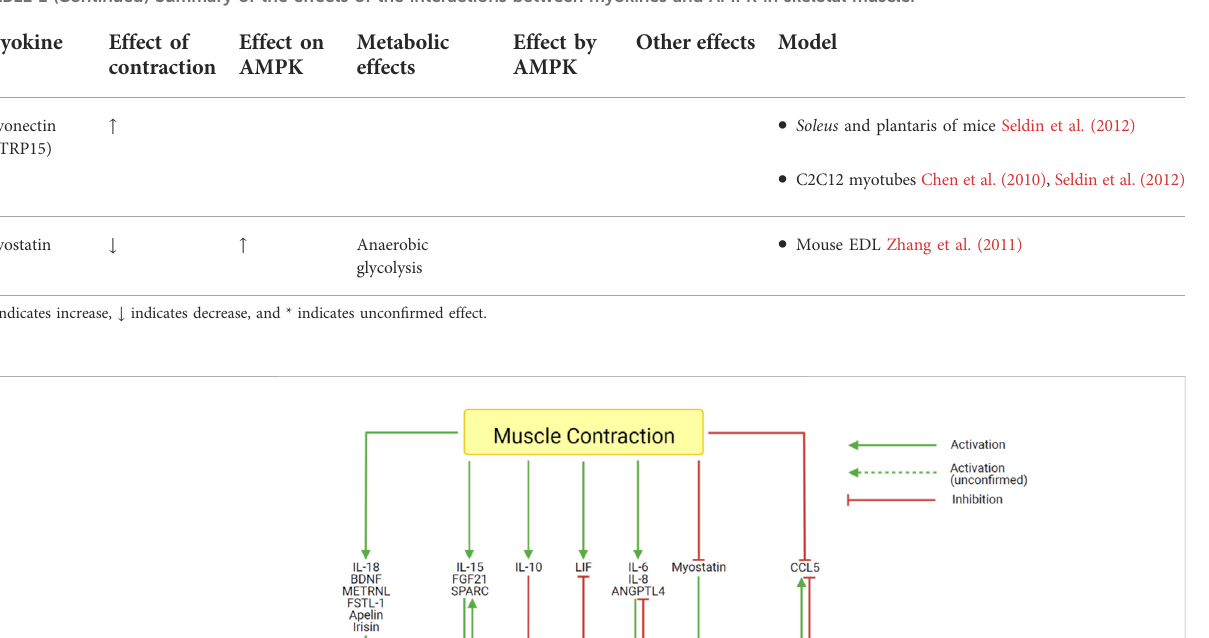
TABLE 1 ( Continued ) Summary of the effects of the interactions between myokines and AMPK in skeletal muscle.